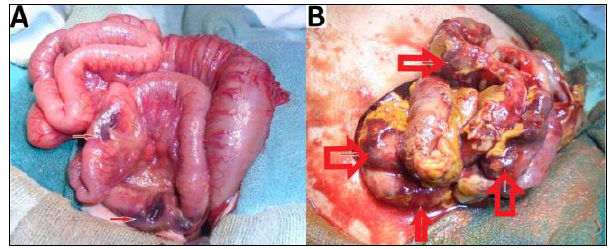
Figure 2: Intraoperative images showing: (A) multiple gangrenous patches in the small intestine (red arrow) and (B) diffuse involvement (ischemia) of small bowel with flakes and pus over gangrenous areas (red